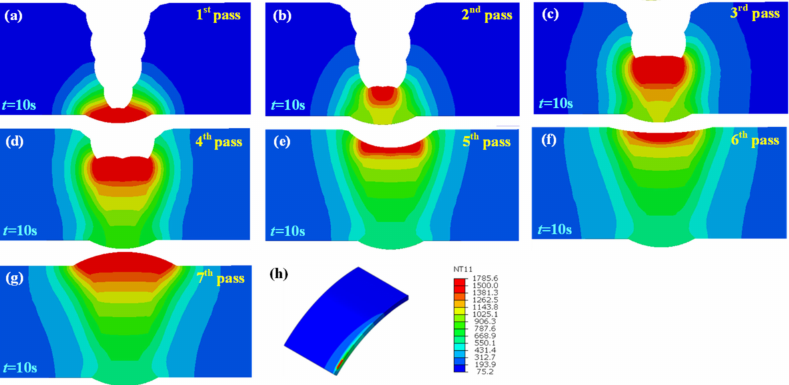
Figure 10. Joint temperature field with 3 mm butt gap: ( a – g ) temperature distribution of each pass, ( h ) isometric view of temperature field.